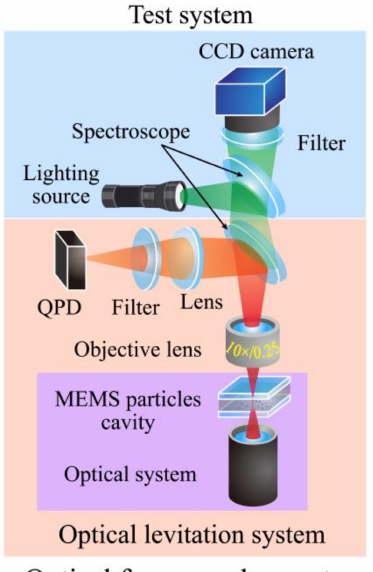
Figure 6. Optical path of the accelerometer and test